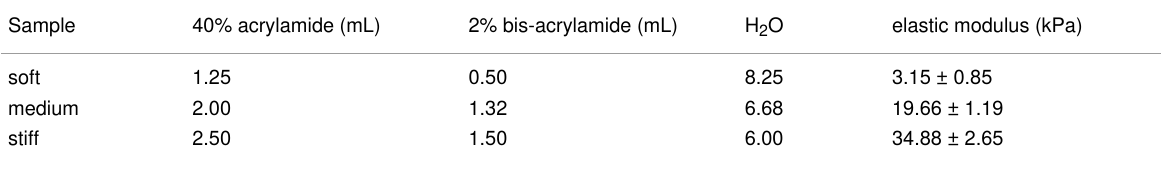
Table 1: Composition ratio of polyacrylamide hydrogel substrates with different stiffness.